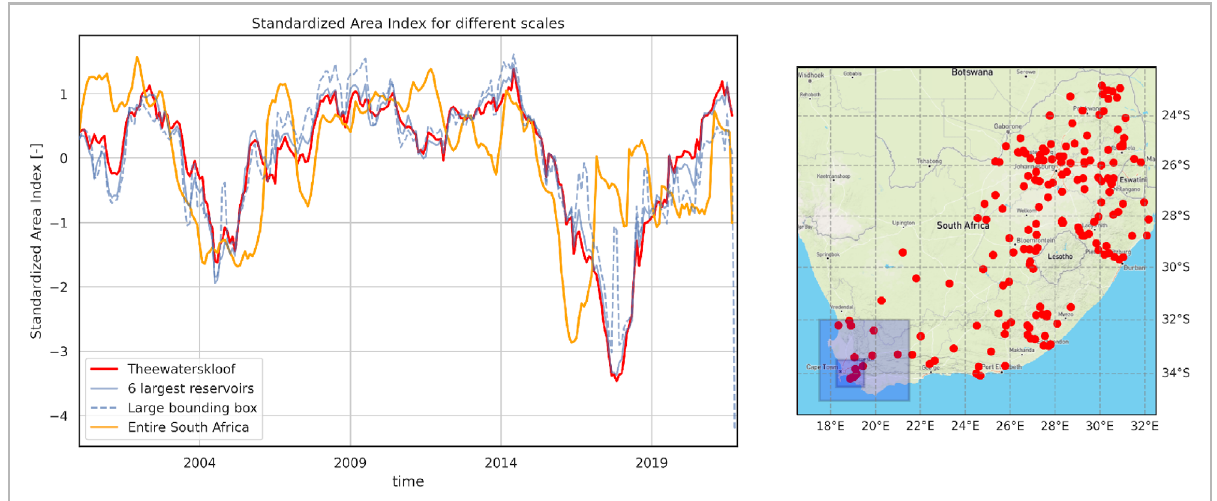
Figure 3. Water dynamics in South African reservoirs. Left: Standardized Area Index (SAI) for Theewaterskloof dam, the six largest dams (> 1 km 2 ) in our database around Cape Town (dark blue bounding box, right side), and a larger bounding box (light blue box, right side). Right: Map in Red all reservoirs in our database > 1 km 2 in South Africa. All of these are included in the SAI of “Entire South Africa” in the left graph. The period 2000 until 2020 is used as reference climatology. The figure is generated using Matplotlib 34 and Cartopy 35 python libraries.